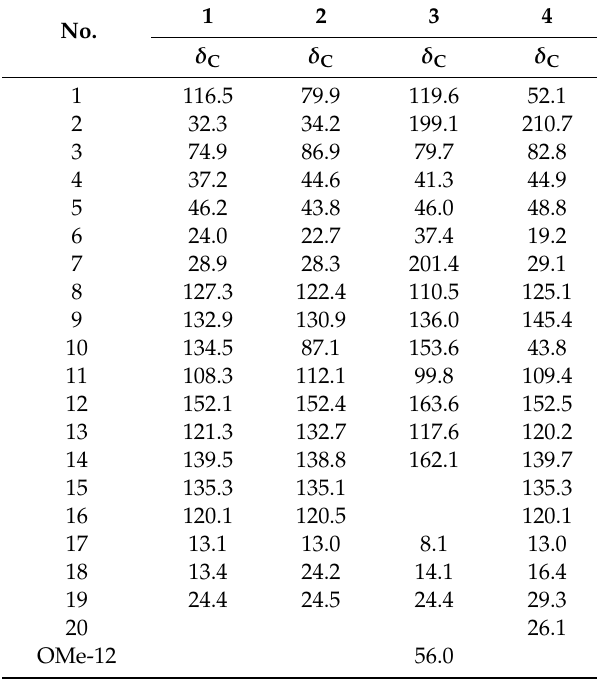
Table 2. 13 C (150 MHz) NMR data for compounds 1 – 4 in CDCl 3